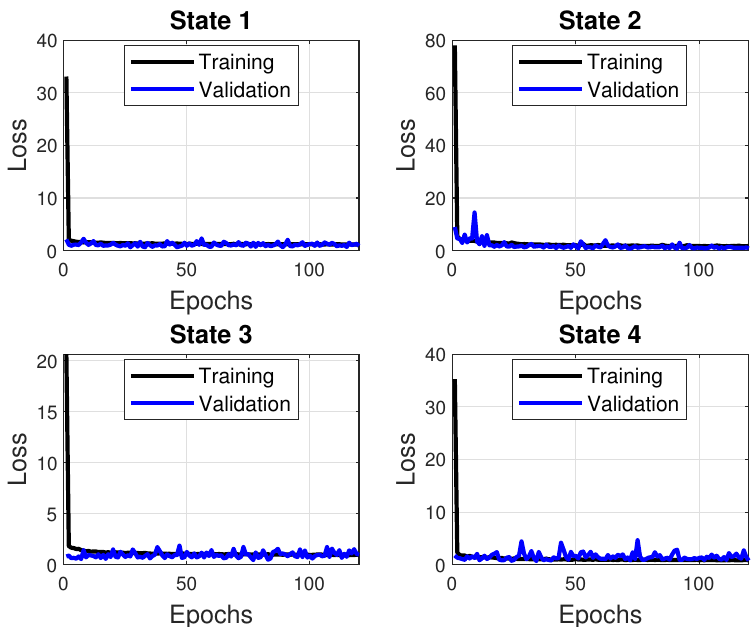
Figure 9. Training and validation MSE losses for